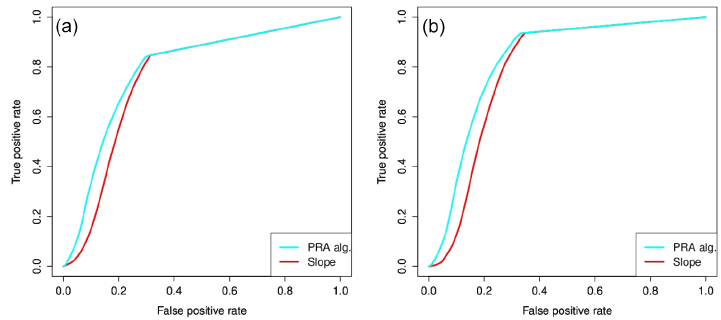
Figure 11. ROC curves for the PRA algorithm and slope for areas for which release occurred at least (a) twice and (b) five times.